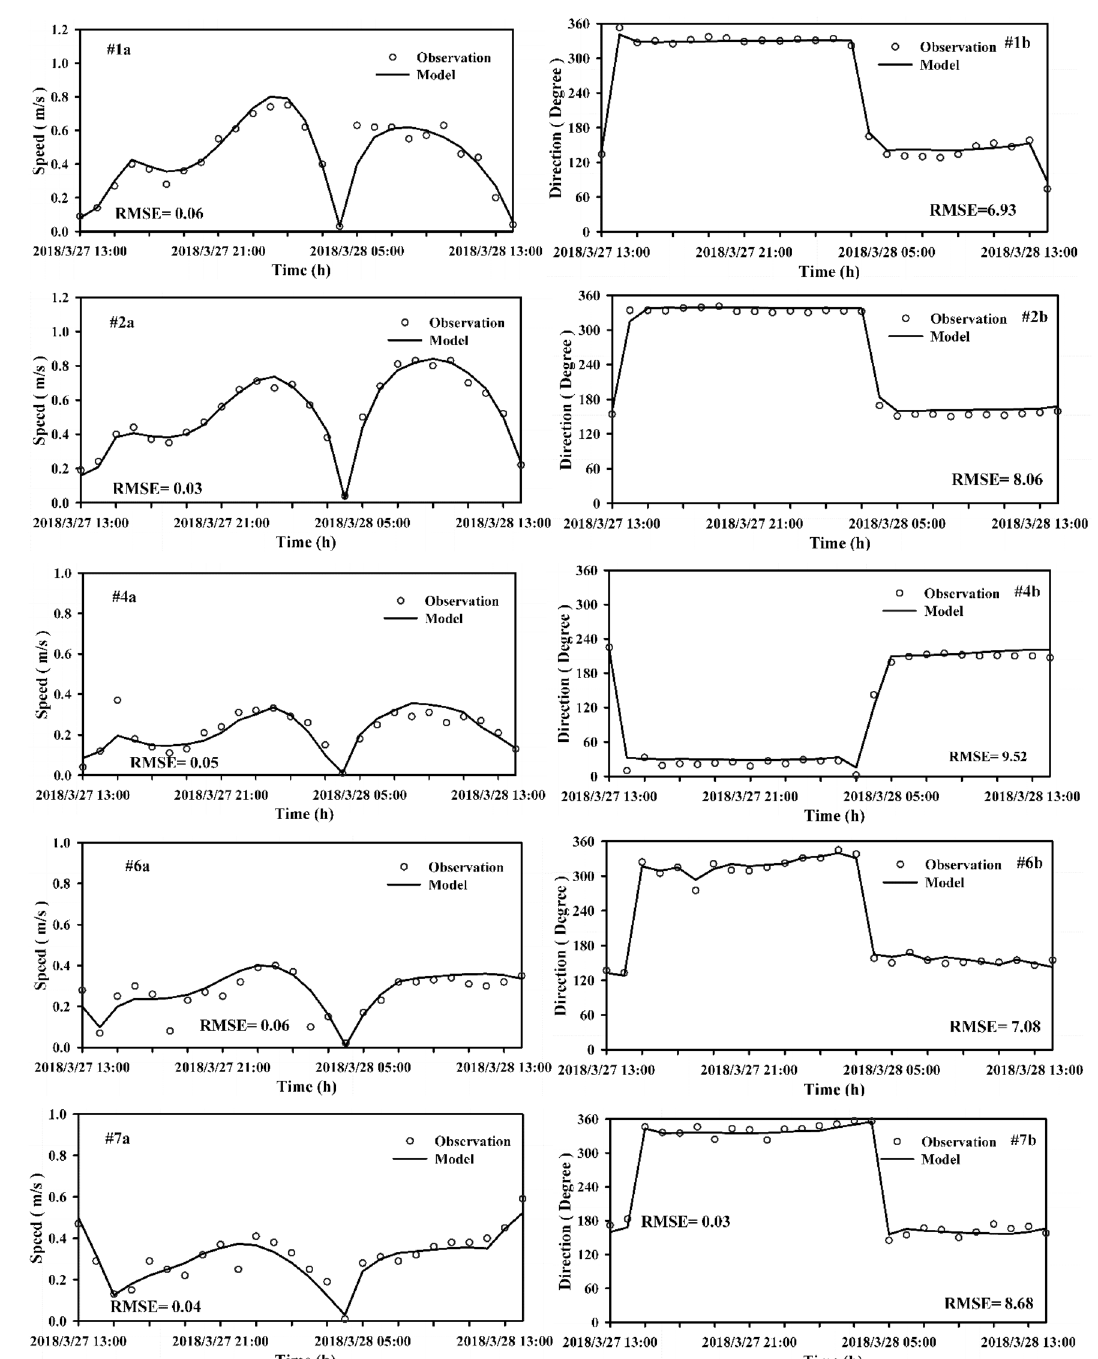
Figure 3. The variations of speed and direction of tidal currents in observation and model with time. These figures were prepared with SigmaPlot Version